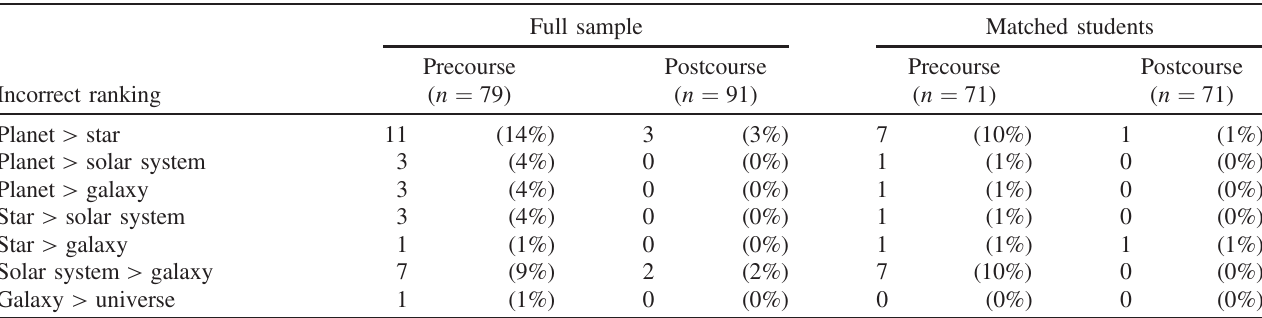
TABLE VI. Students ’ errors on the ranking task, both pre- and postcourse. The leftmost column indicates errors made (e.g., the first entry corresponds to planets being bigger than stars), and the next columns give the numbers and percentages of students who made these